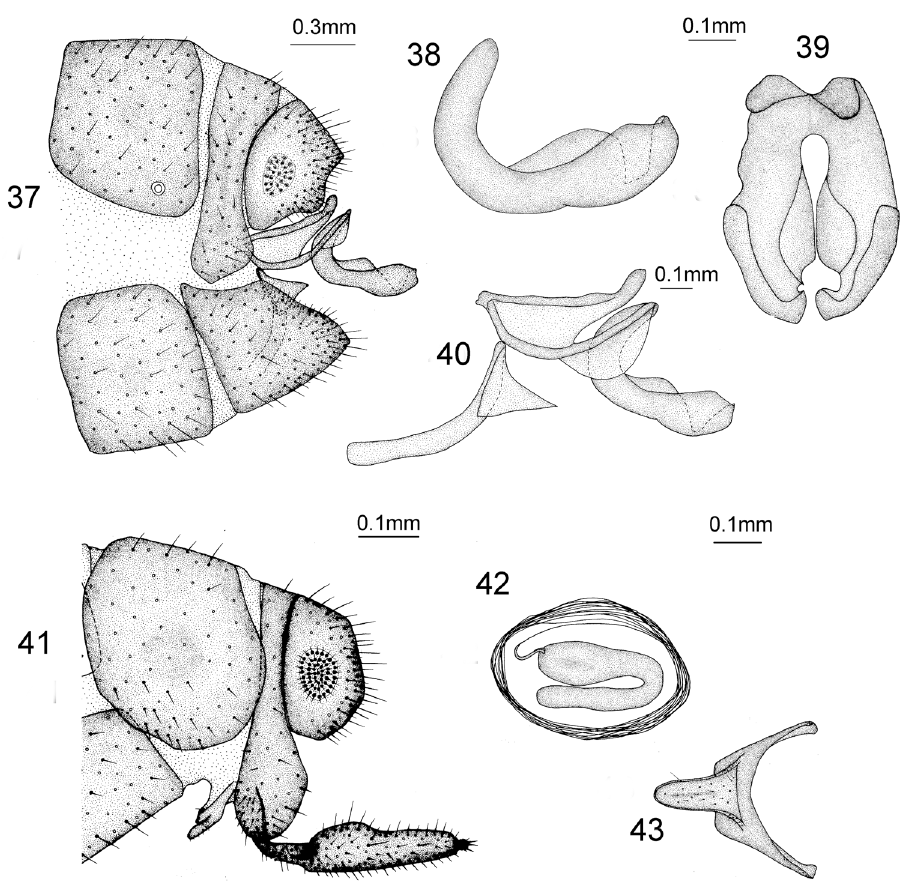
Figures 37–43. Heterosmylus shennonganus Yang, 1997. Male 37 terminalia, lateral view 38 mediun- cus, lateral view 39 mediuncus, dorsal view 40 genitalia, lateral view. Female: 41 terminalia, lateral view 42 spermatheca, lateral view 43 8 th sternite, ventral view.